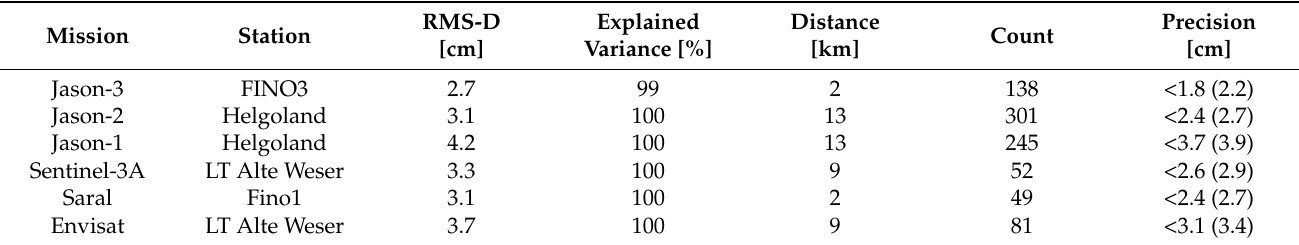
Table 3. RMS-D, explained variance, number of values and distance between the gauge and virtual station for each mission for the best fitting station pair. The altimeter precision is estimated assuming that tide gauges have a precision of 2 cm (1.5 cm).